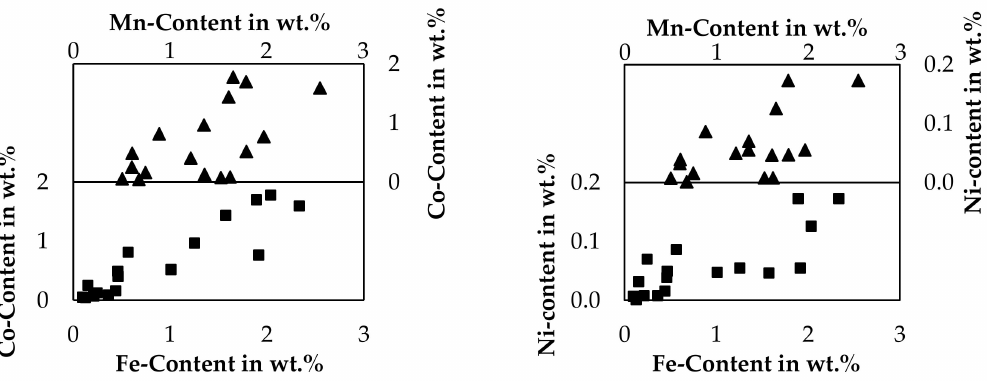
Figure 10. Relations of valuable metal content in slag samples compared to iron- and manganese